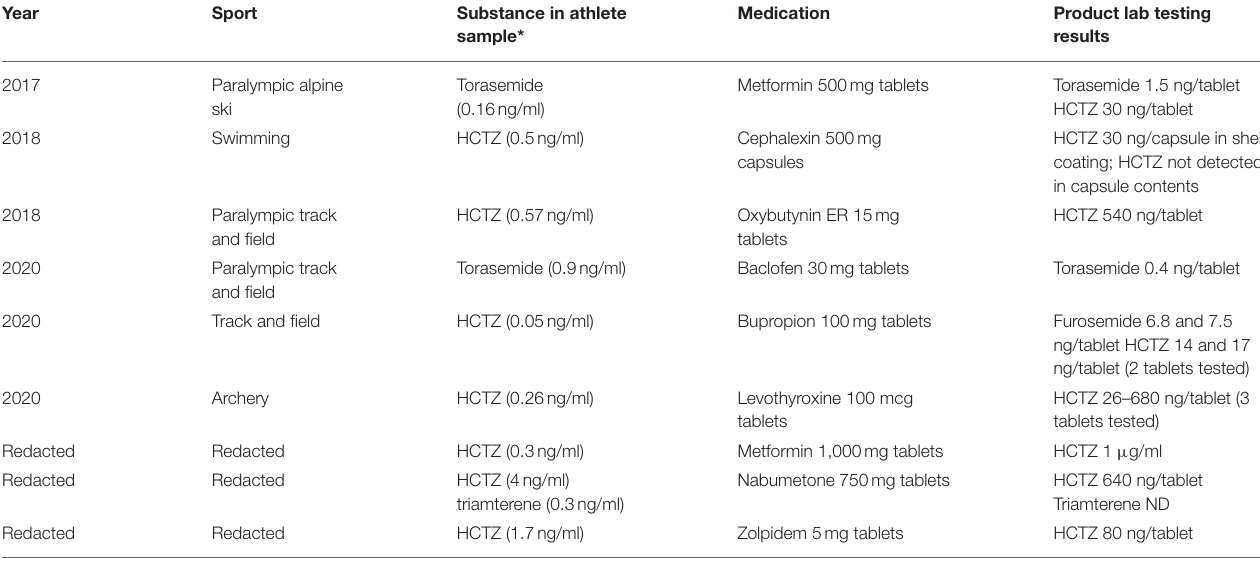
TABLE 1 | Summary of nine positive athlete samples at USADA where a generically manufactured prescription medication was found to be